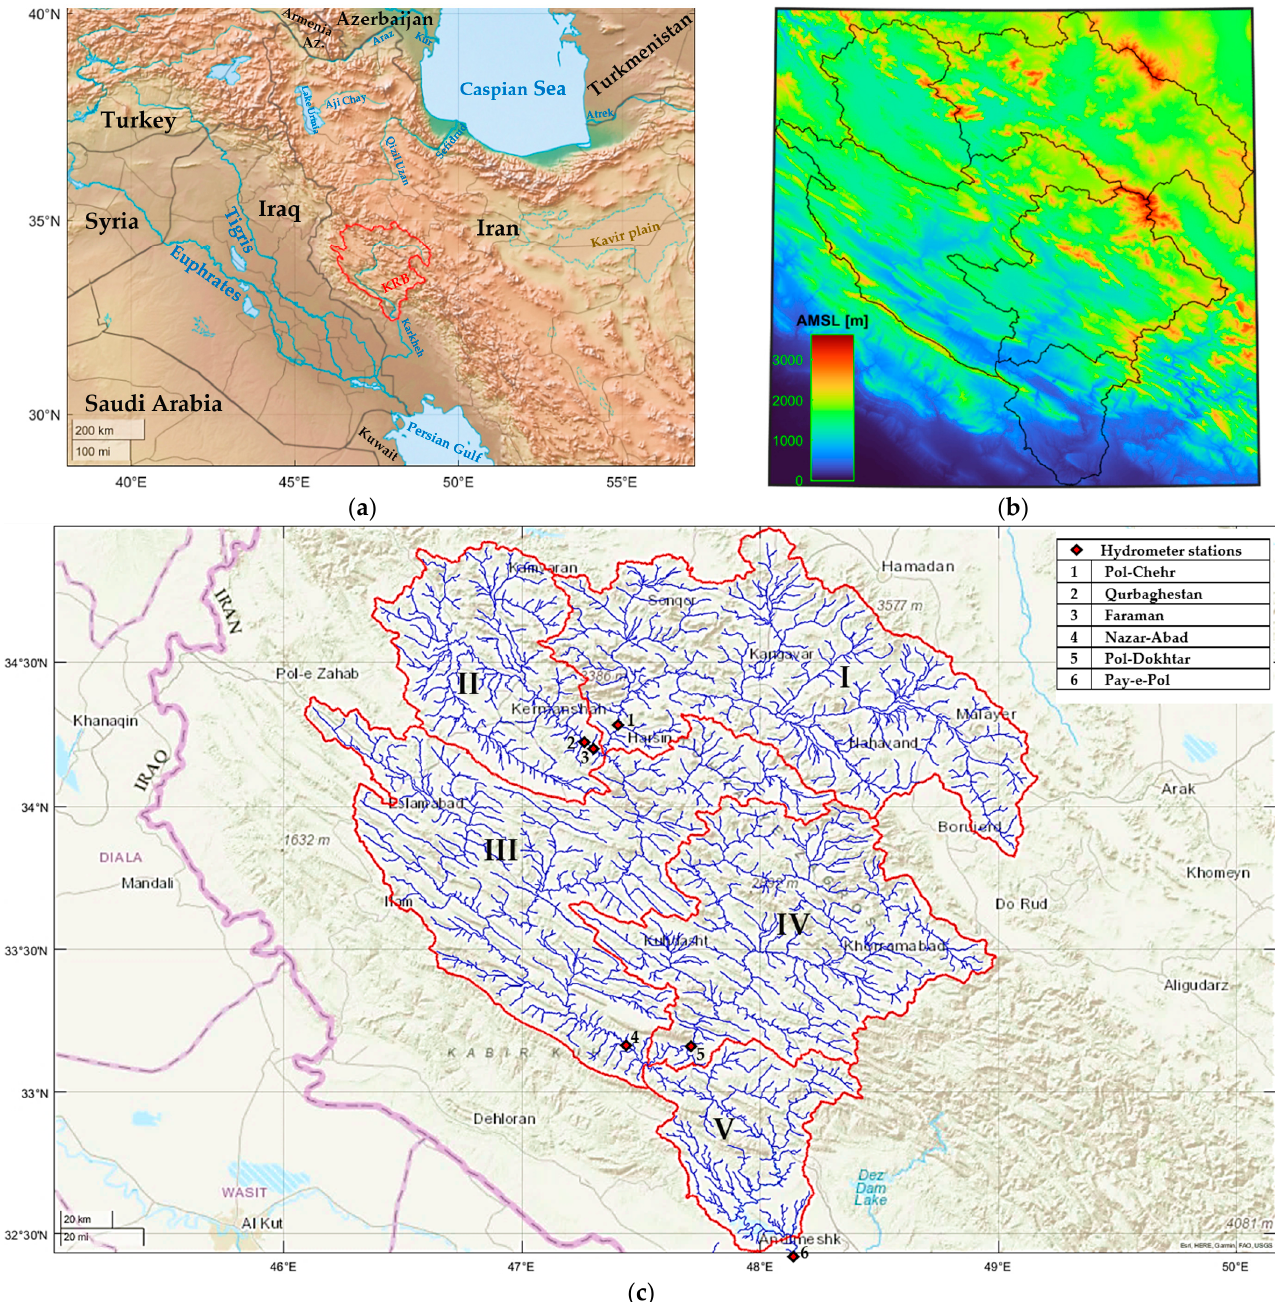
Figure 1. Location of the KRB upstream of the Karkheh Dam in west Iran ( a ), and its elevation map ( b ) over sub-catchment areas ( c ) of Gamasiab (I), Qarasu (II), Seymareh (I–III), and Kashkan (IV). The entire study area of KRB covers all areas I–V.